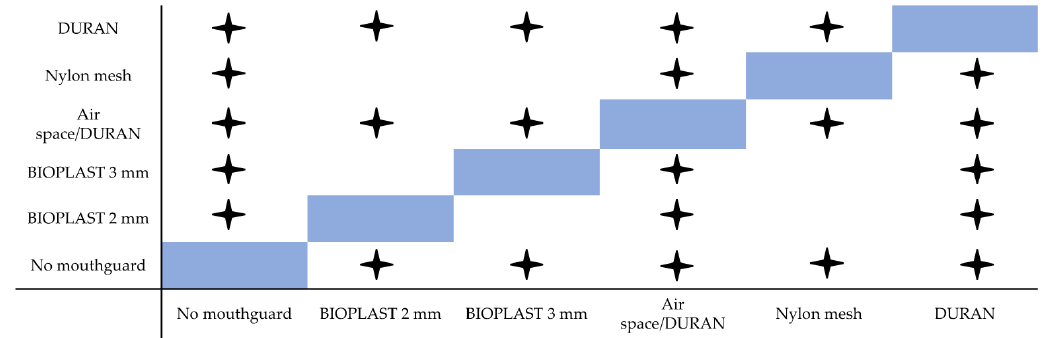
Figure 5. Statistical comparison of all five mouthguards and no mouthguard results with 90 ◦ pendulum energy blows (generated energy: 1.15